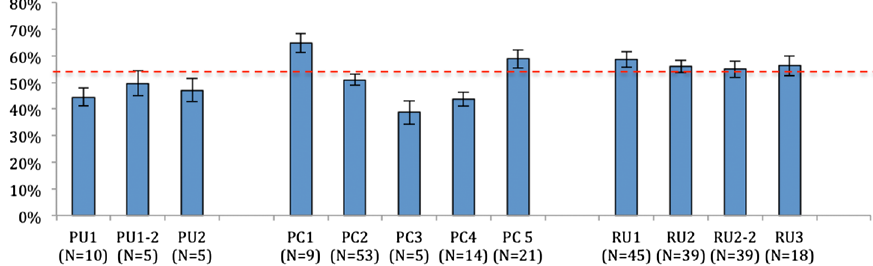
FIG. 7. Students ’ mean scores on the beta version of QMCA, organized based on the type of university. (Repeated name codes mean consecutive semesters at the same institution) N is the number of students in the class. The red dashed line represents the weighted average for all students across different institute, which was 54%.